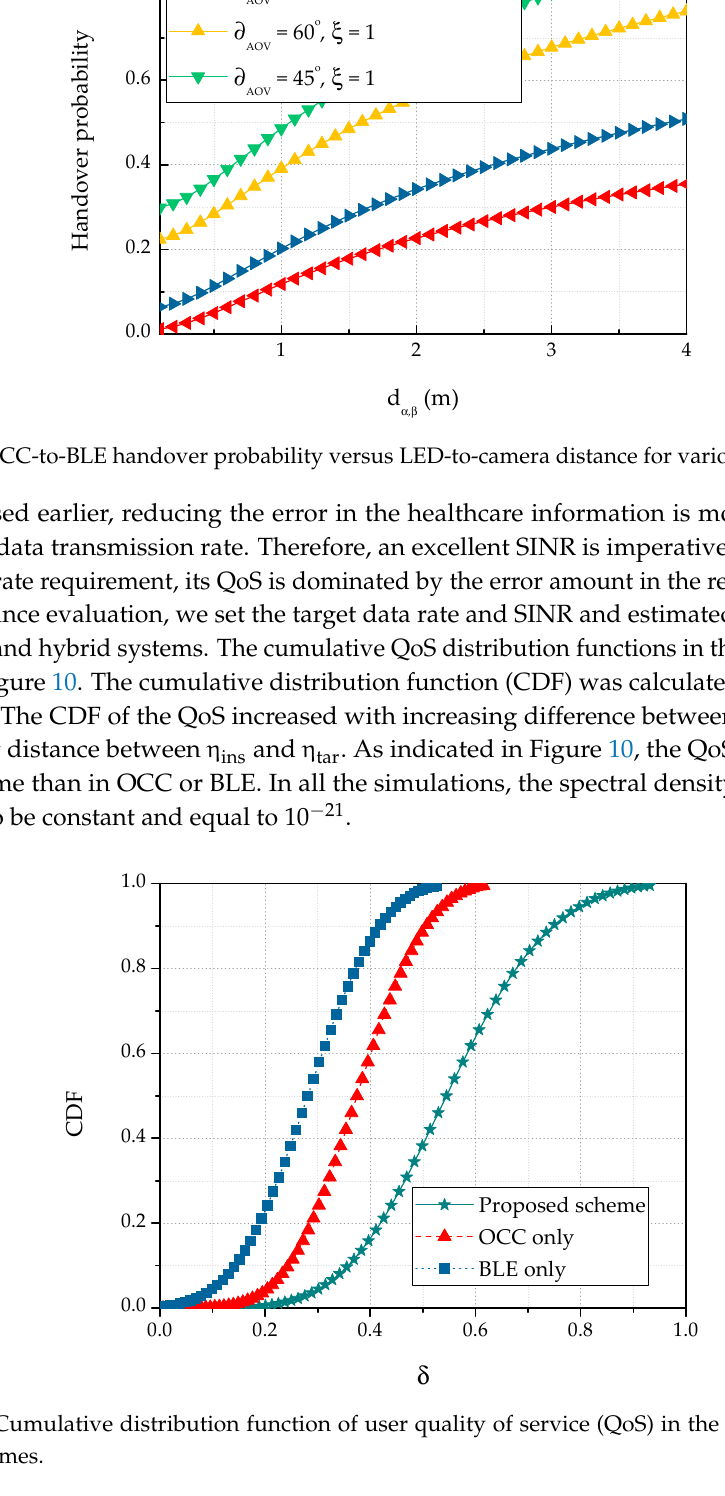
d α , β (m) O P_OCC O P_BLE Proposed scheme Figure 8. Comparison of the outage probabilities in the OCC, BLE, and proposed schemes. Network switching becomes important when monitoring mobile patients in these scenarios. When patients move, the changing